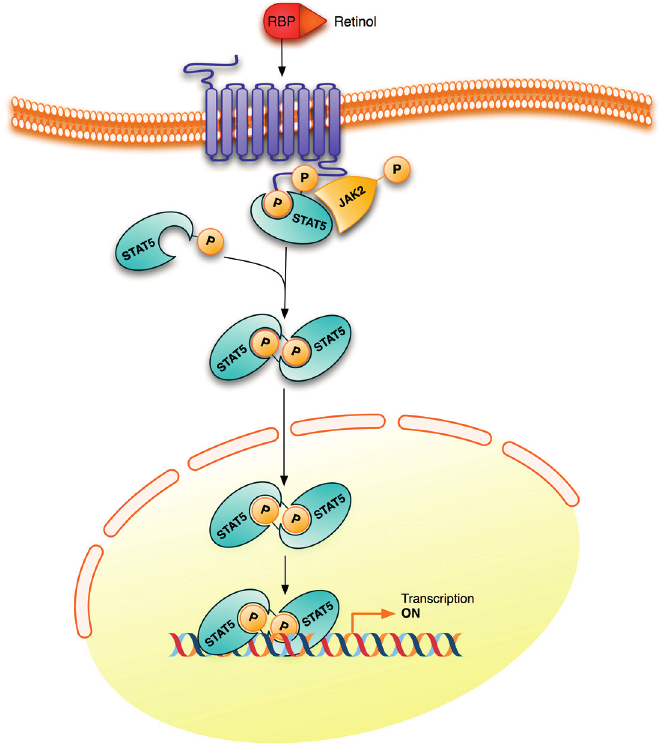
Figure 4. Retinol signaling. STRA6 is not only a plasma membrane transporter for